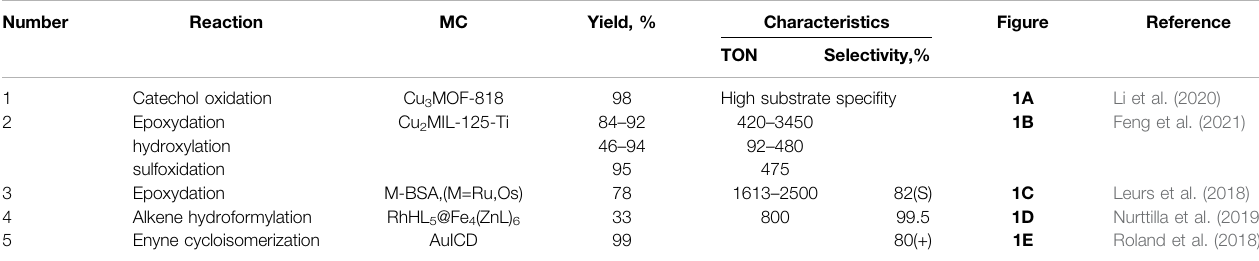
TABLE 1 | Some examples of MC catalysis of organic